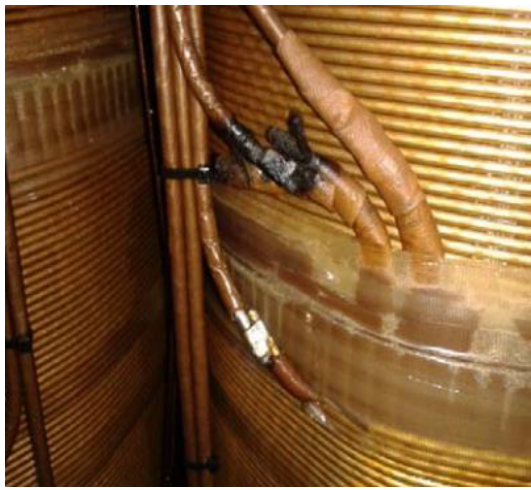
Figure 13. Damage identified during an internal inspection of a 2.7 MVA, 30/0.06 kV power